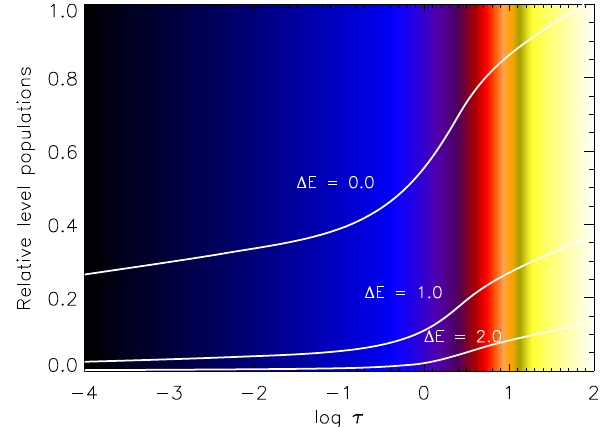
Fig. 1 Relative LTE populations for three atomic levels of an atom with energies Δ E = 0, 1 and 2eV from the ground state (assuming the same level degeneracy) as a function of Rosseland optical depth ( τ ) in the solar atmosphere. The populations are arbitrarily normalized to be unity for the ground level in the innermost layer shown. The color in the background indicates temperature, increasing from black (about 3000K) to white (about 10,000K). At the layers relevant for line formation, typically − 3 < log τ < 0, the populations of levels separated by 1eV differ by a factor of about